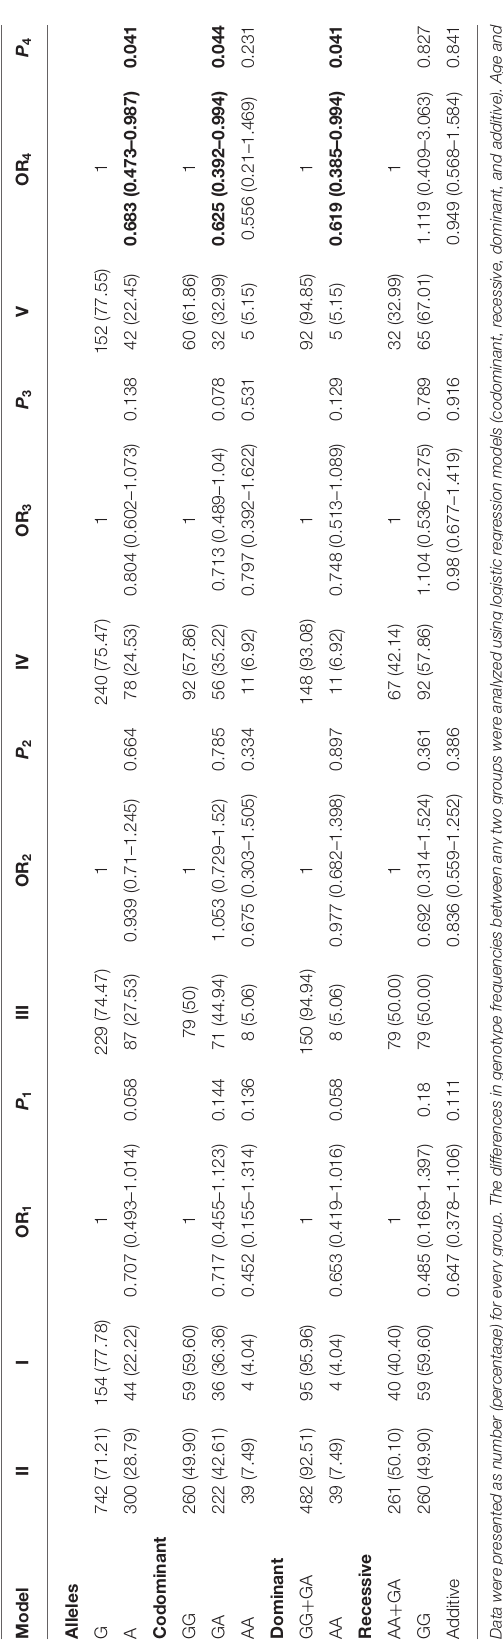
Supplementary Table 3 . The call rates for rs1229984 and rs671 were 100%. Those variants in the control and case-patient group were in accord with Hardy–Weinberg equilibrium ( p >